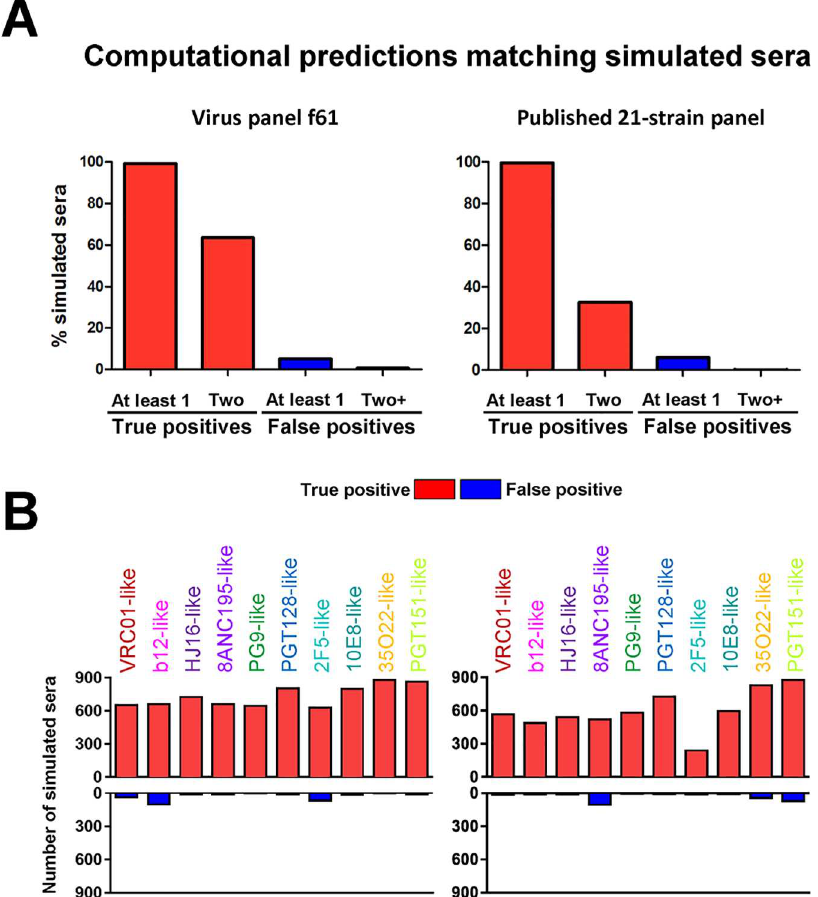
Fig 3. Computational comparison of f61, a selected 20-strain virus panel, to the published 21-strain panel. Both panelswere evaluatedon the test set of simulatedsera. (A) Percent of simulatedsera with one or two true positive (red) and one or two+ false positive (blue) signals. (B) Number of simulatedsera with true positive (red, out of a maximum of 900) and false positive (blue) signalsfor each of the ten antibody specificities from the reference set